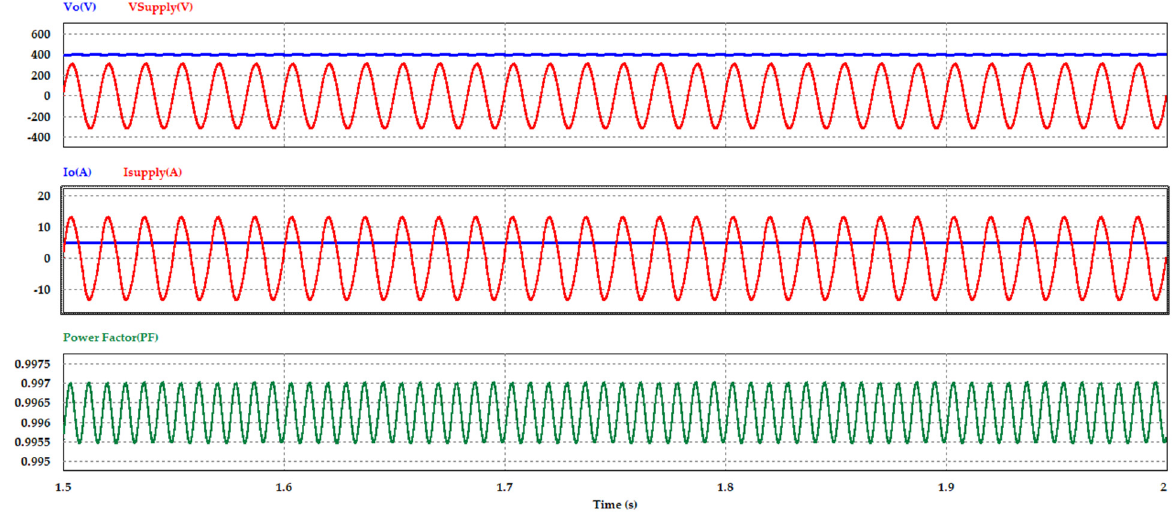
Figure 13. PSIM simulation circuit for the PFC topologies: ( a ) conventional boost PFC; ( b ) interleaved boost PFC.